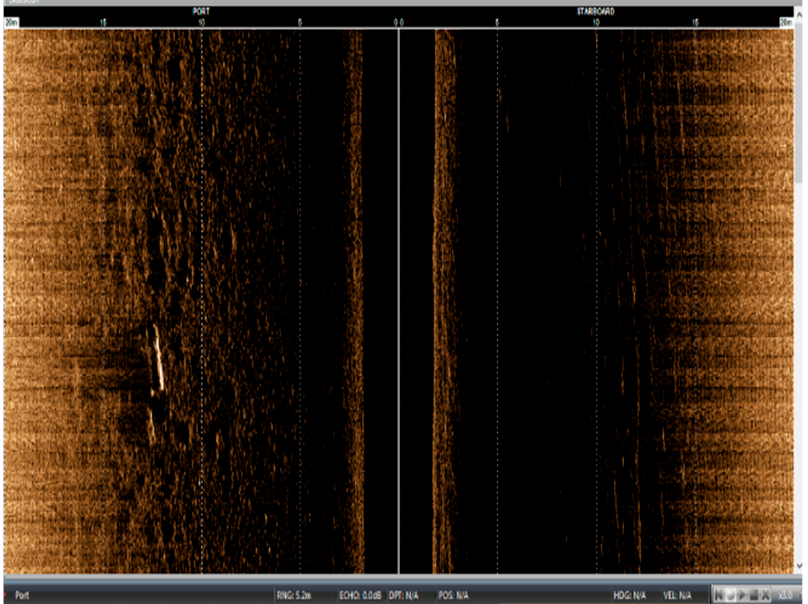
Figure 13. Sonar image with cumulative effort applied to the WAM-V with cables separated. (The object on the left is the same object as the object on the left seen in Figure 12.)